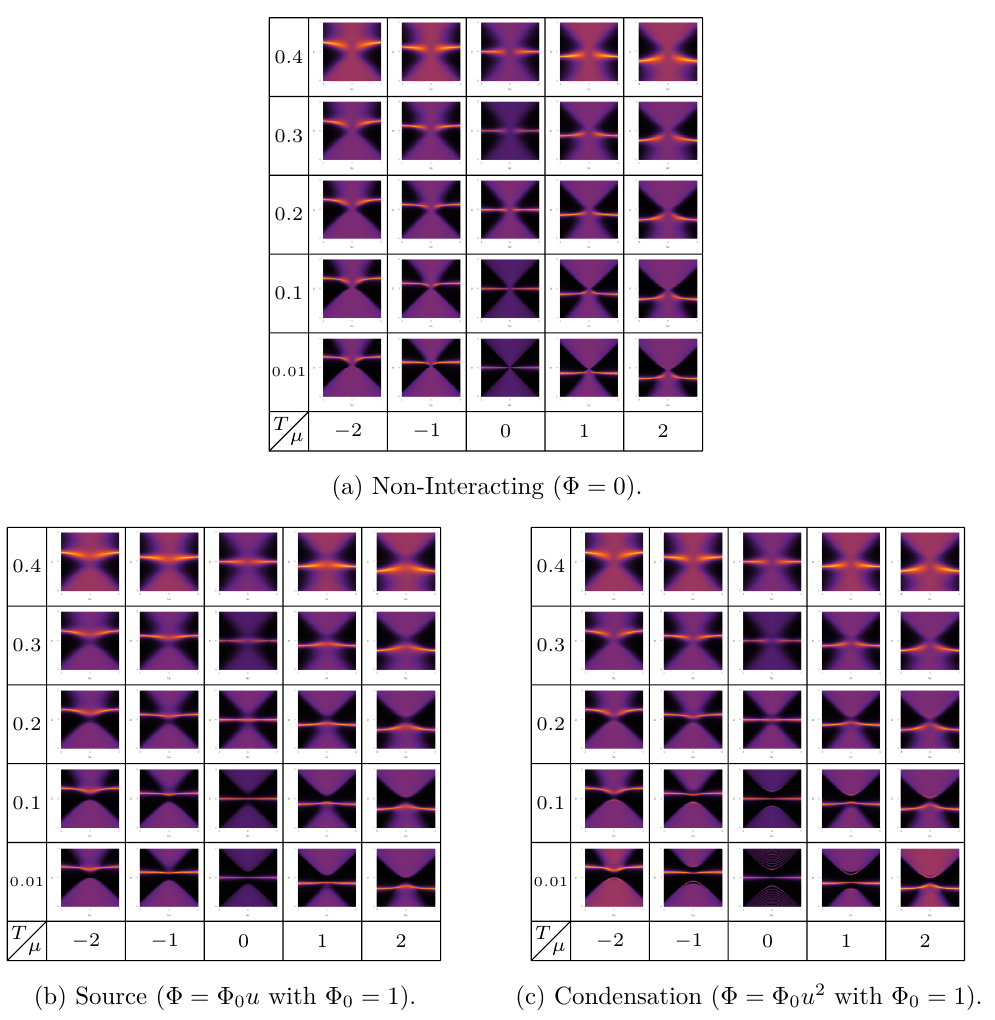
Figure 7 . Evolution of the effects of charge density and temperature in the mixed quantization. The tables show the spectral density functions for various density and temperature T in k x – ω plane (a) without Yukawa interaction, (b) with interaction of fermion with scalar source, and (c) with interaction of fermion with scalar